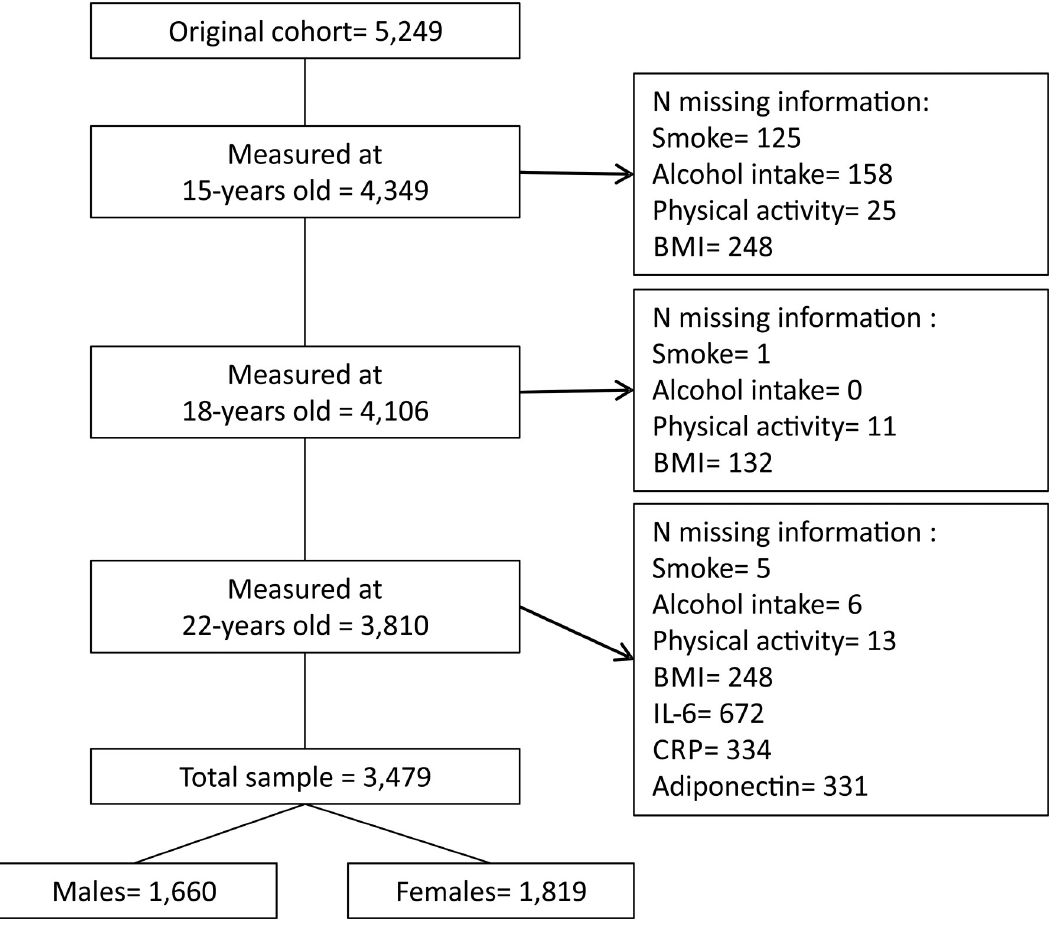
Fig 1. Sample flowchart. The 1993 Pelotas Birth